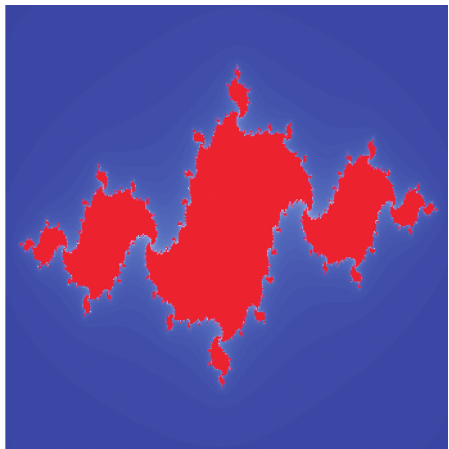
Figure 2: Quadratic Julia set in JSOmhh.